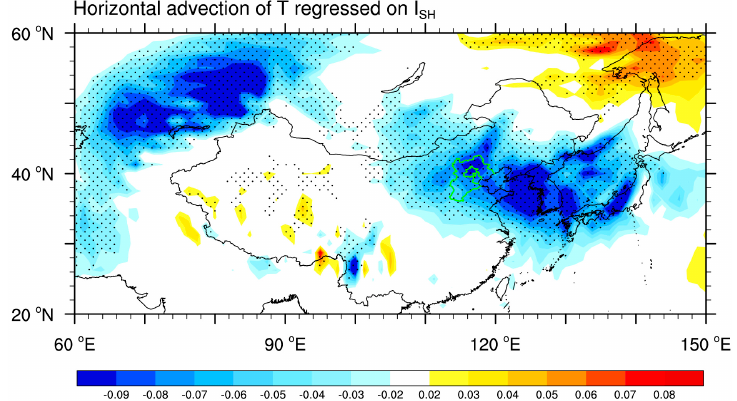
Figure 5. Regressed the vertically integrated temperature advection from the surface to 100 hPa by I SH . Regression coefficients exceeding the 95% confidence level are stippled. Green curve indicates the BTH region.